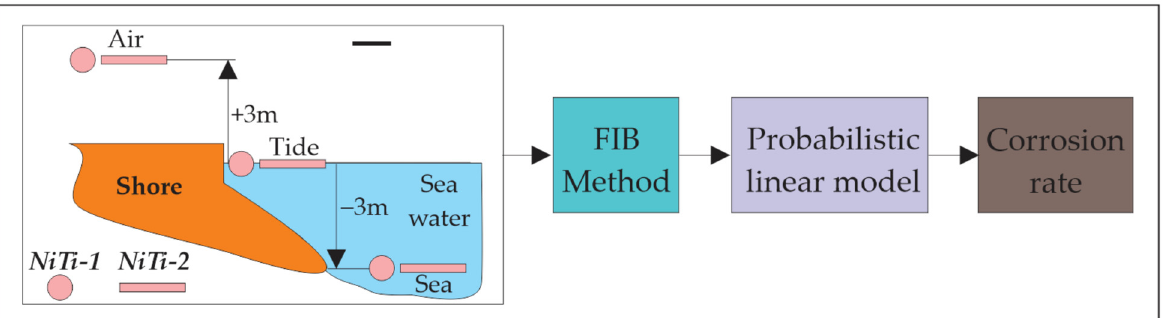
Figure 3. The scheme of the research conceptual